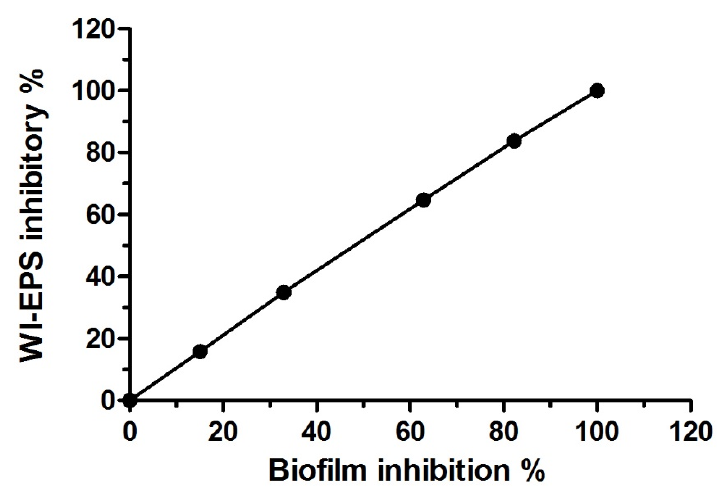
Figure 4. Scatter plot showing correlation between mean biofilm and WI-EPS inhibitory percentage at di ff erent AKFA concentrations (R = 1, p < 0.0001).